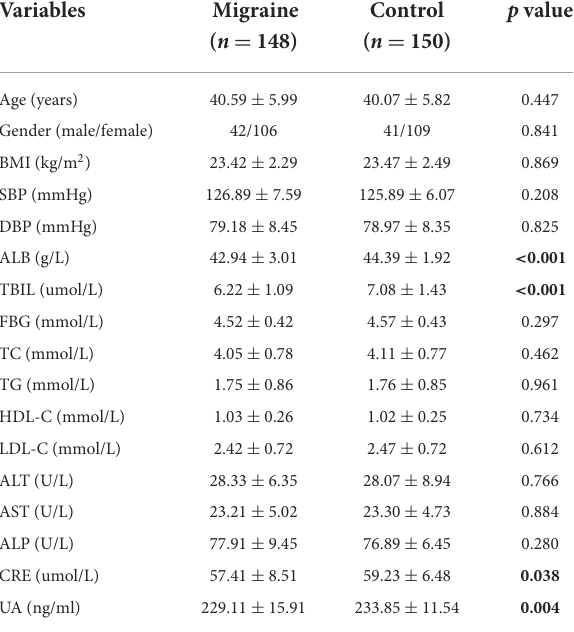
TABLE 1 Clinical features and laboratory data of patients with migraine and controls.